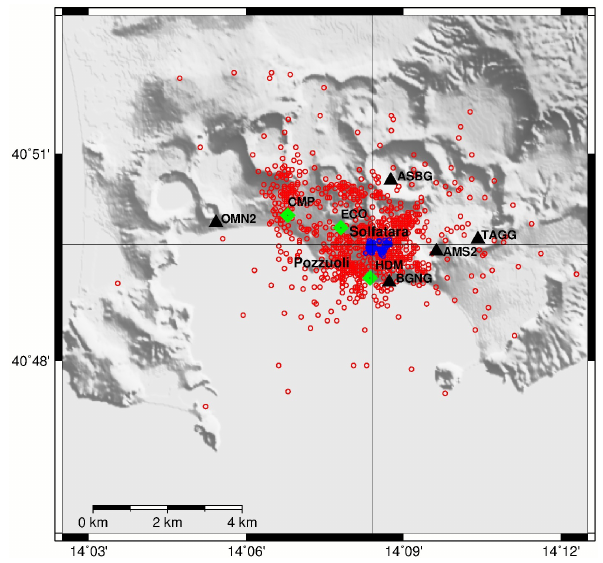
Figure 2. Map of the Campi Flegrei area with the three borehole tiltmeters (green diamonds) and the five seismic stations (black tri- angles) used for the analysis of the LP seismicity occurred in Octo- ber 2006. The locations of the LPs in the Solfatara area are shown by blue circles. The map also reports the locations (red circles) of the VT earthquakes recorded by the INGV-Osservatorio Vesuviano seismic network in 2005–2016.